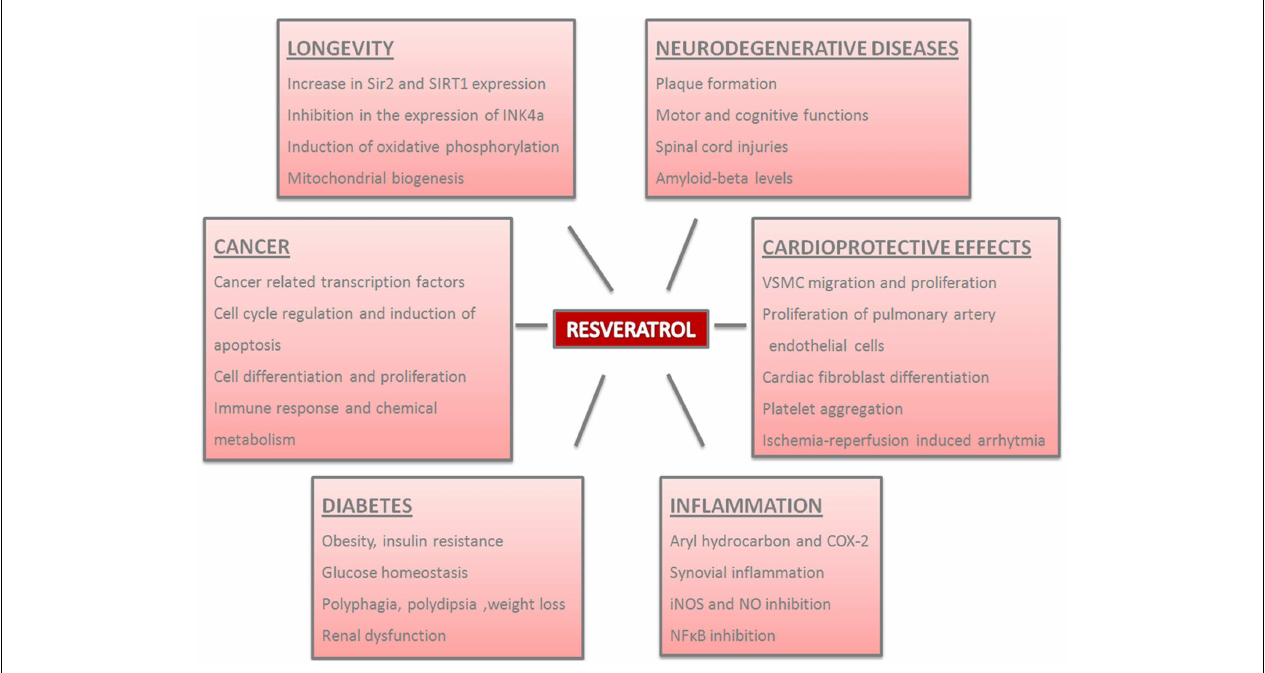
FIGURE 1 | Physiological and pathological effects of resveratrol in the organisms. Resveratrol plays important roles in distinct processes and the parameters of these effects are summarized.